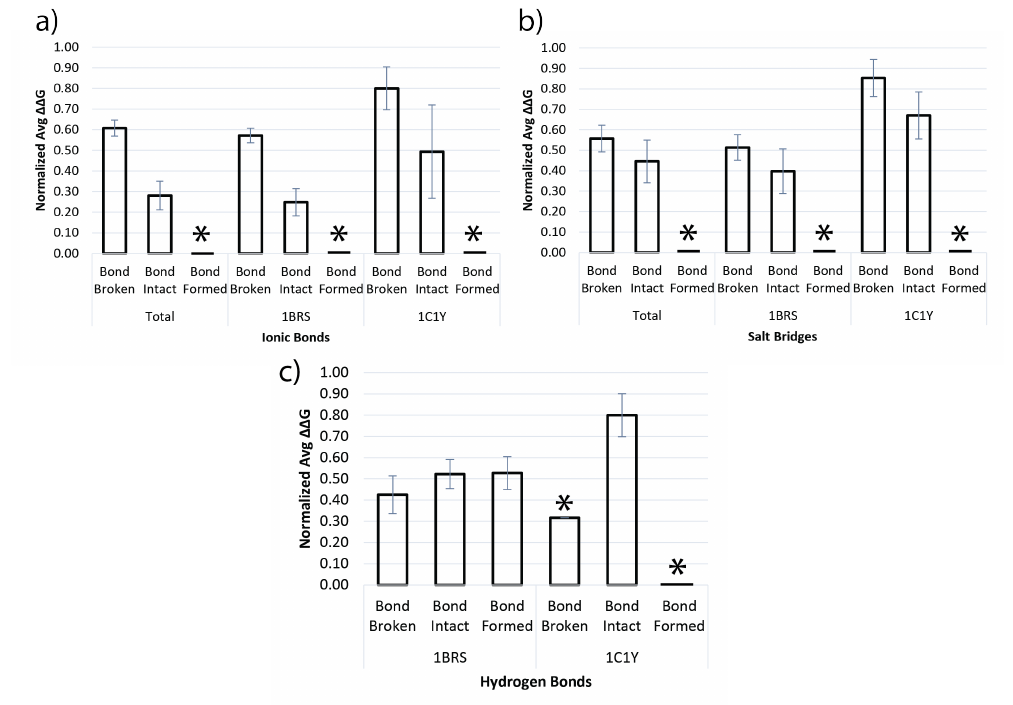
Figure 4. Comparison of ∆∆ G when a bond is broken and when a bond remains intact for ( a ) Ionic bonds, ( b ) Salt Bridges, and ( c ) Hydrogen bonds. Each bond compared using normalized average ∆∆ G values for Barnase-Barstar (1BRS) and Rap1a-raf (1C1Y). (*) indicates that no bonds were predicted by DiffBond in those groups. Rap1a-raf hydrogen bond had only one bond broken prediction, so no intervals were